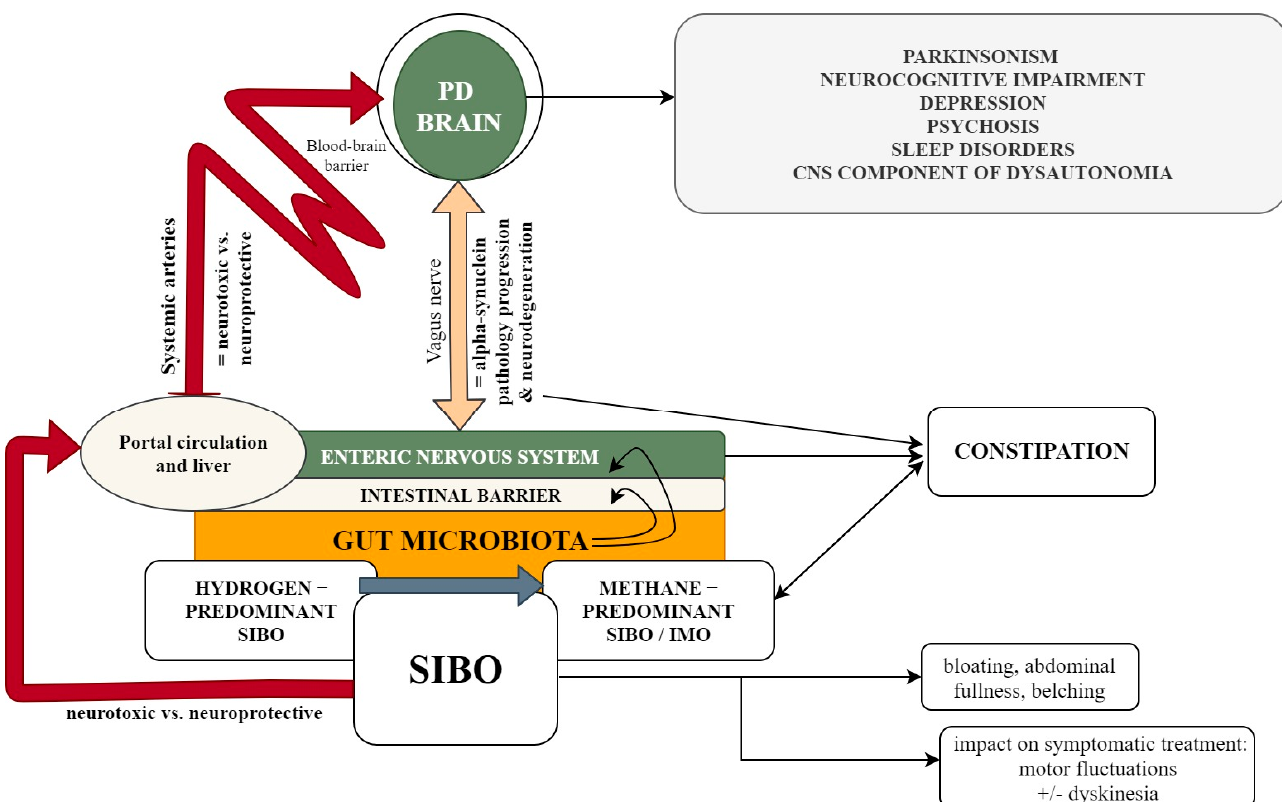
Figure 1. The relation between SIBO and specific characteristics of sporadic PD. The figure illustrates the potential relations between SIBO and specific clinical characteristics of sporadic PD, highlighting the potential pathogenic mechanisms that underlies these relations. SIBO may result in increased intestinal production of H 2 and/or methane, with potential neuroprotective and neurotoxic consequences; H 2 may also modulate the composition and function of the microbiota, for example by being substrate for hydrogenotrophic methanogenic archaea (see the main text), which may have potential indirect consequences on PD progression, both beneficial and deleterious. Gut dysbiosis, including SIBO, may alter the integrity of the intestinal barrier, thus exposing the central nervous system, via the neuronal and humoral pathways of the gut–brain axis, to microbial and non-microbial xenobiotic compounds that may have amyloidogenic or neurotoxic effects. On a clinical level SIBO may exacerbate (or alleviate) gastrointestinal symptoms related to PD, a potential connection existing between methane overproduction and the presence of constipation. SIBO may also interfere with drug bioavailability, interfering with their overall effect (i.e., symptomatic improvement, occurrence of side effects); this may be of particular importance in patients with advanced PD, that have motor fluctuations and dyskinesia.